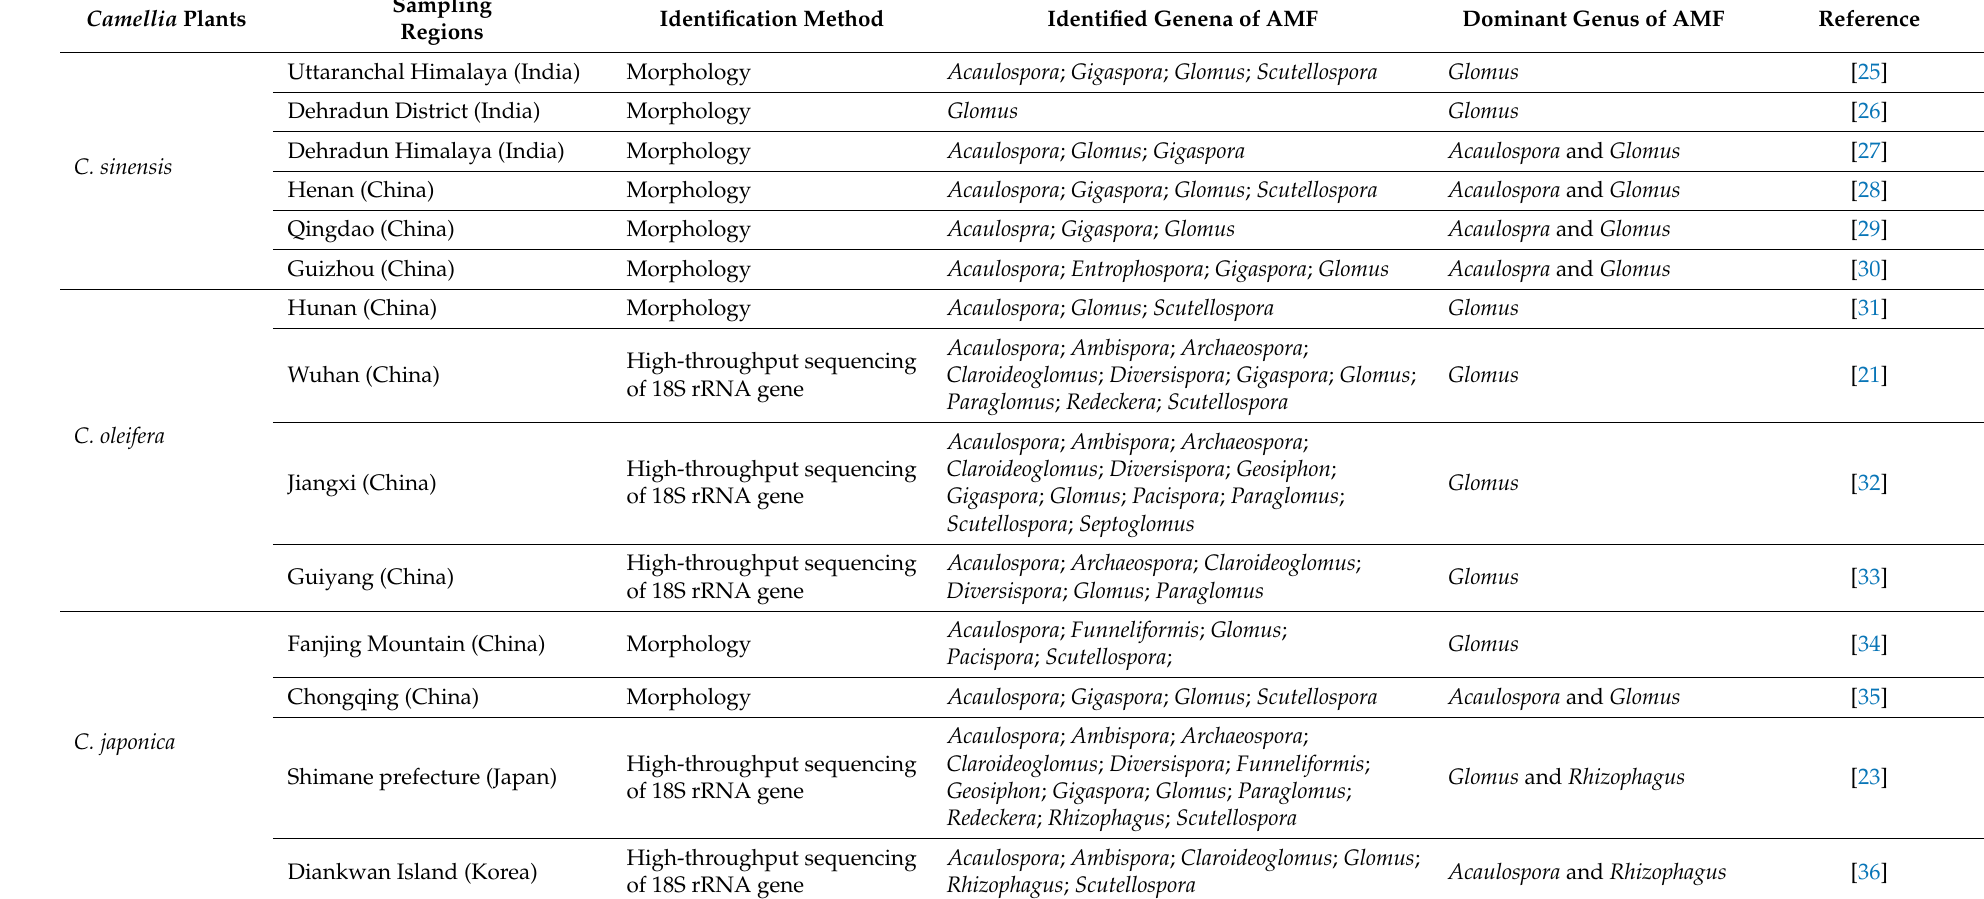
Table 1. AMF diversity of Camellia